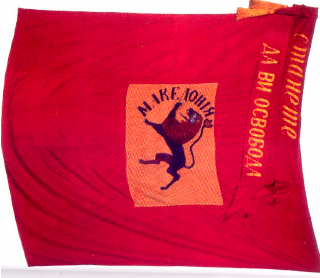
Figure 11. Lion form the Razlovci Uprising flag.